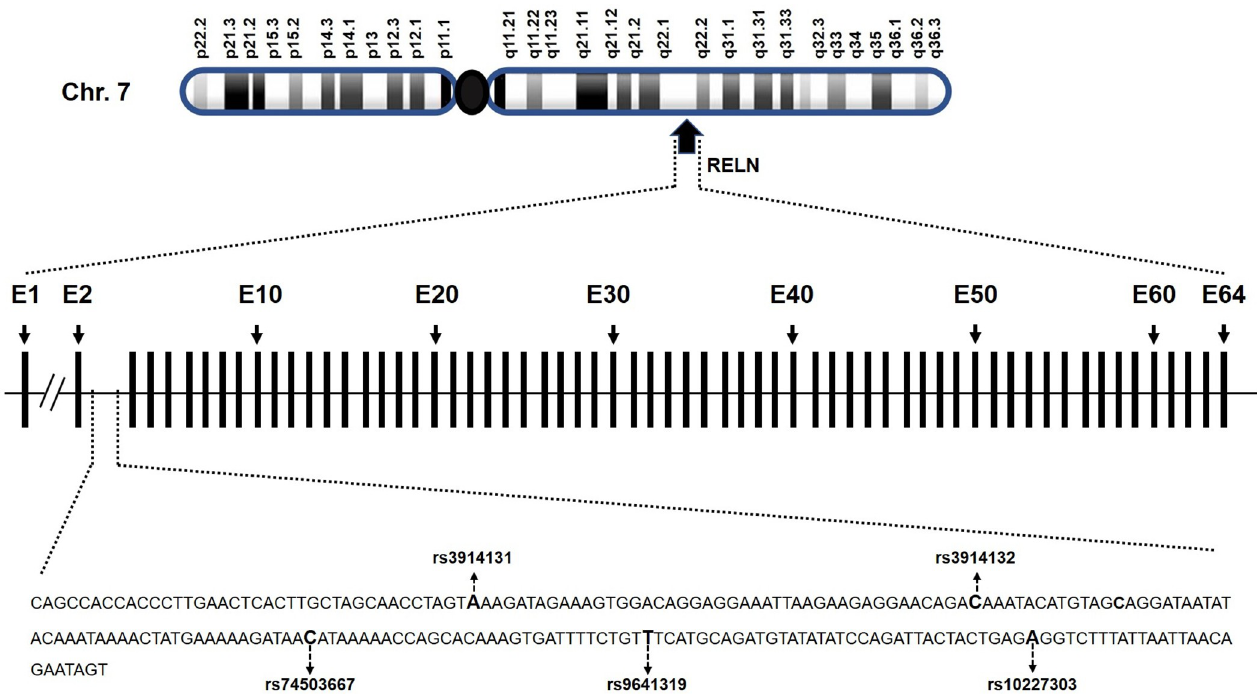
Fig 1. Genomic location and organization of RELN gene. RELN gene consists of 64 exons (E1-E64). Four known polymorphisms were detected in intron 2 region of otosclerosis cases and controls. A rare variant rs74503667 was found in a familial case of otosclerosis.